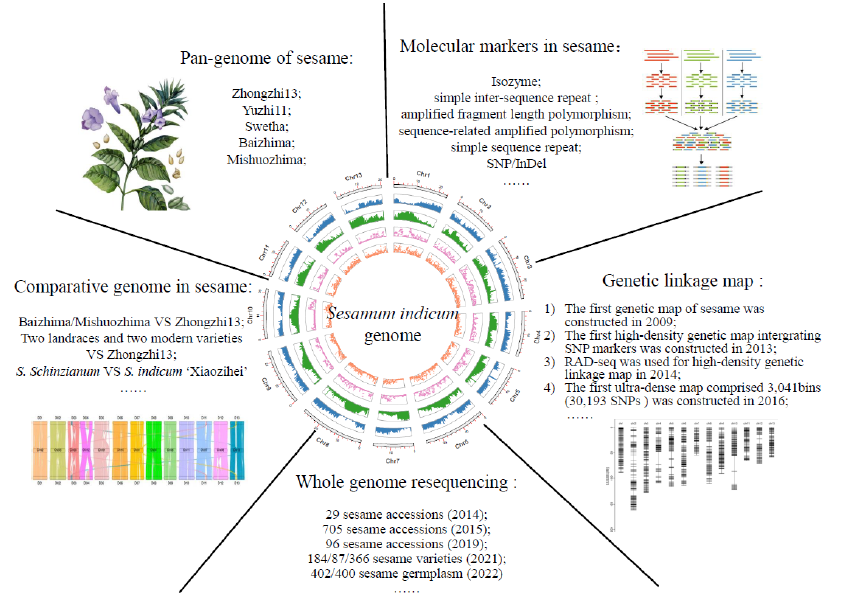
Figure 1. The applications of genomic approaches in sesame, including molecular markers, genetic linkage map, whole genome resequencing, comparative genome and pan-genome.